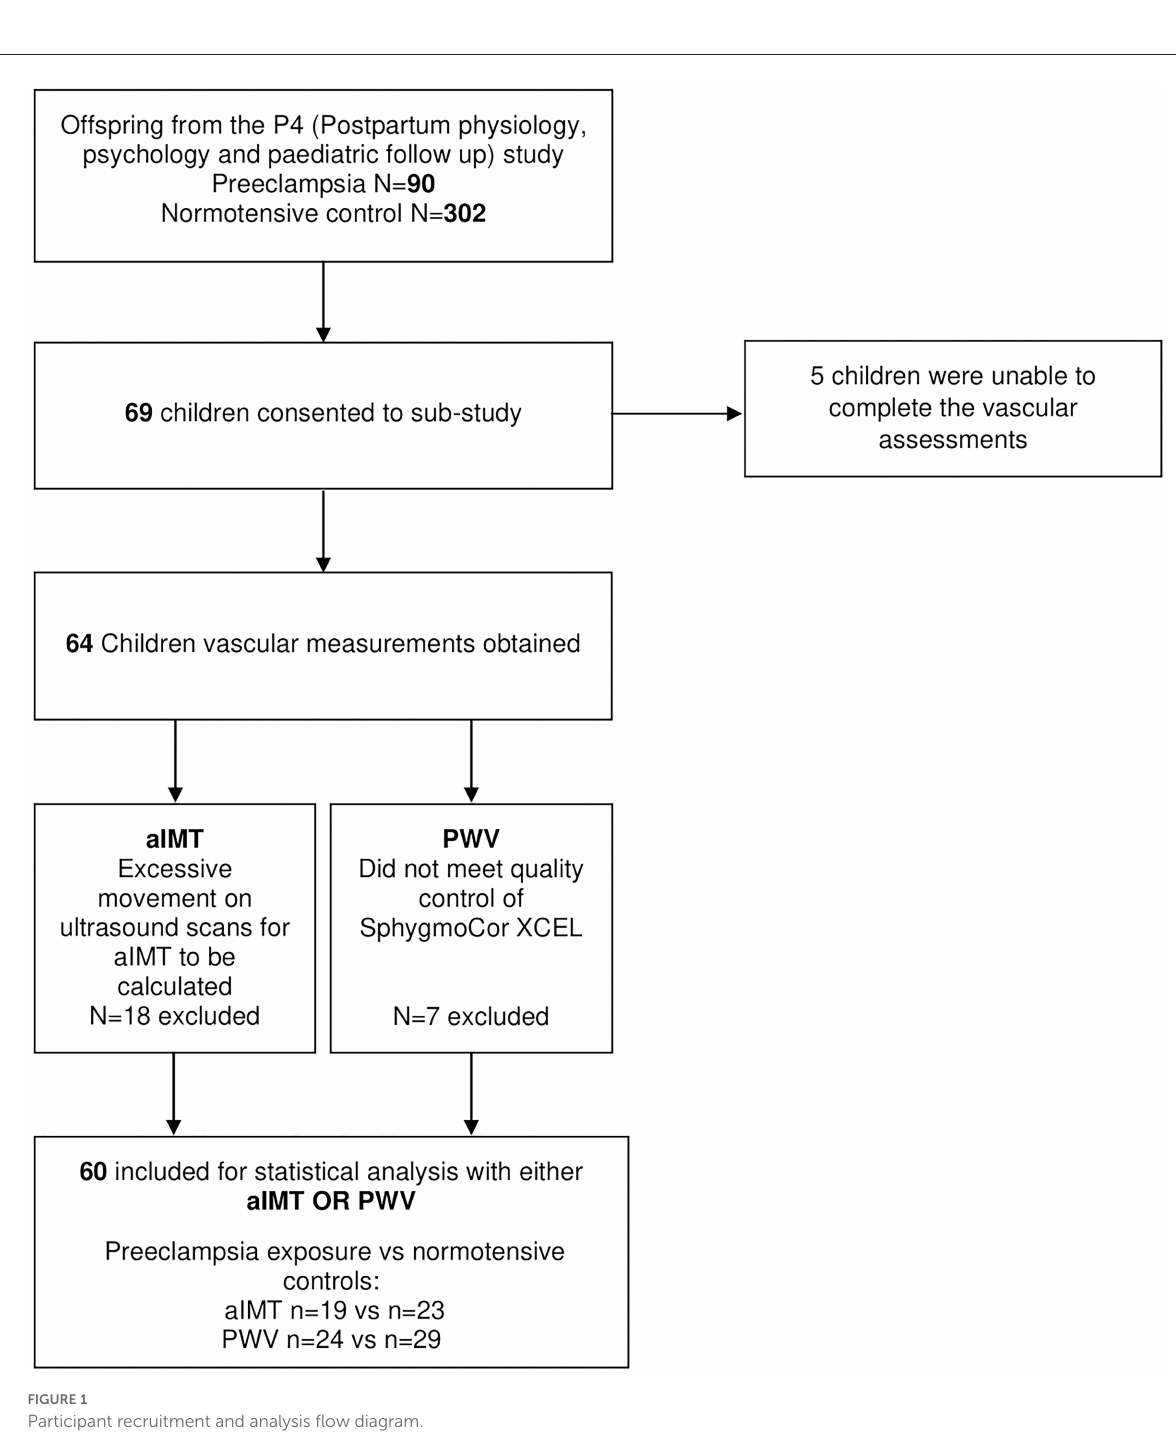
There were no significant associations between vascular measurements and explanatory variables in univariate analysis. Moreover, there were also no differences in aIMT or PWV in sub-group analysis by preeclampsia onset, BP severity and gestational age (results not